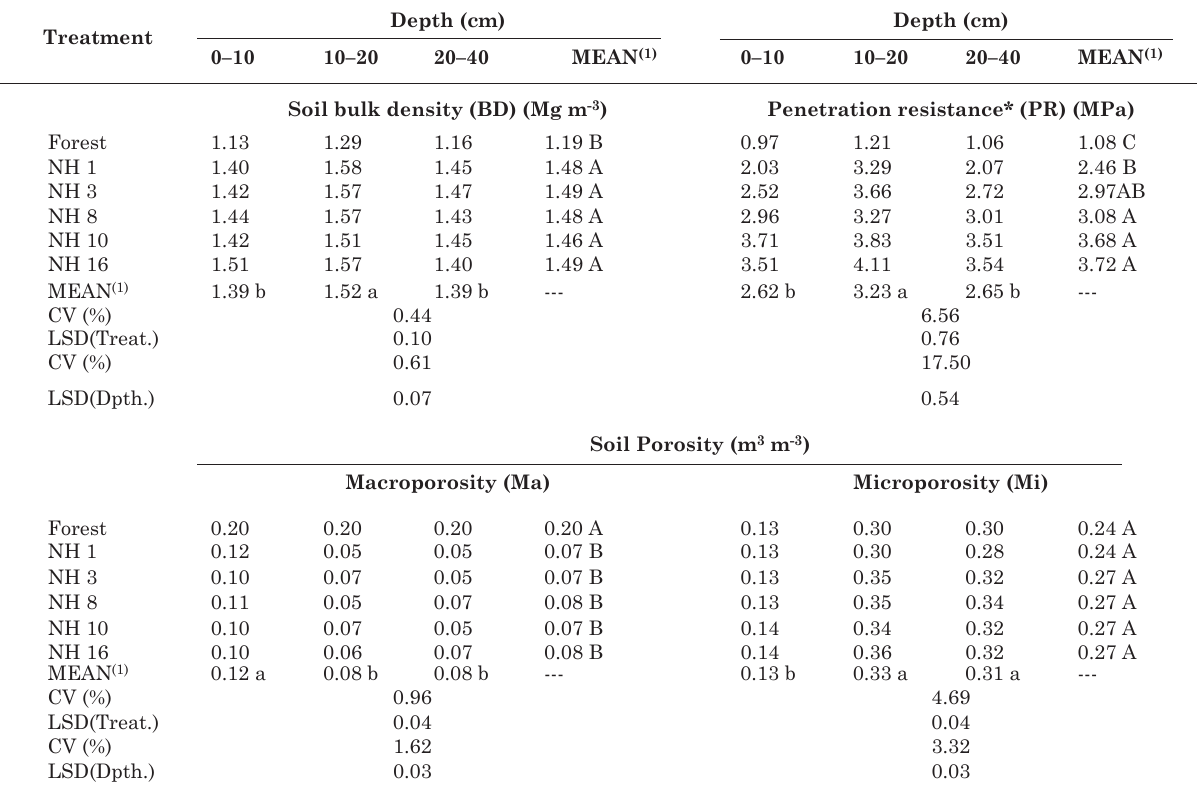
table 2. Values for soil bulk density (Bd), soil penetration resistance (Pr), macro (Ma) and microporosity (Mi) in three layers of a eutroferric red oxisol (latossolo Vermelho eutroférrico) under sugarcane for different cultivation periods (number of harvests - nh) and under native forest